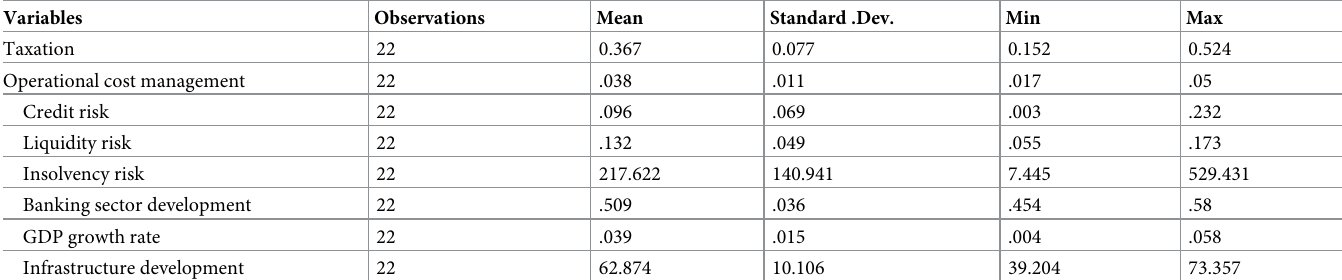
we used lagged of dependent variables in our model. The significant coefficient values of lagged dependent variables (NIM.ROE, ROA and PBT) confirm the dynamic character of our model specification. The Hansen-j test is used to check the validity of instruments because of its consistency in the presence of heteroscedasticity and autocorrelation[120]. We used the sys- tem GMM model proposed by [112] for first and second order serial correlation. The results show autocorrelation exists in the first- order for all four models but it does not mean that our estimates are inconsistent. The inconsistency of the model would be implied if a second-order correlation exists [112], which is rejected by the AR(2) test. The significant positive value of